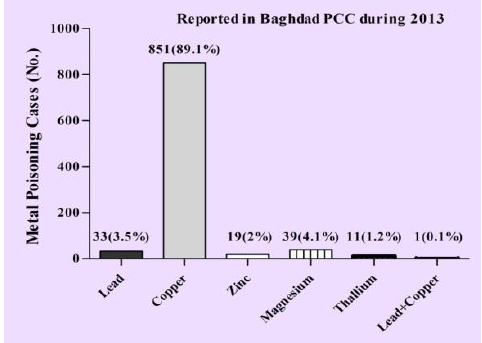
Figure (8): Distribution of metal-induced poisoning cases reported in Baghdad PCC during 2013 according to the metal type.